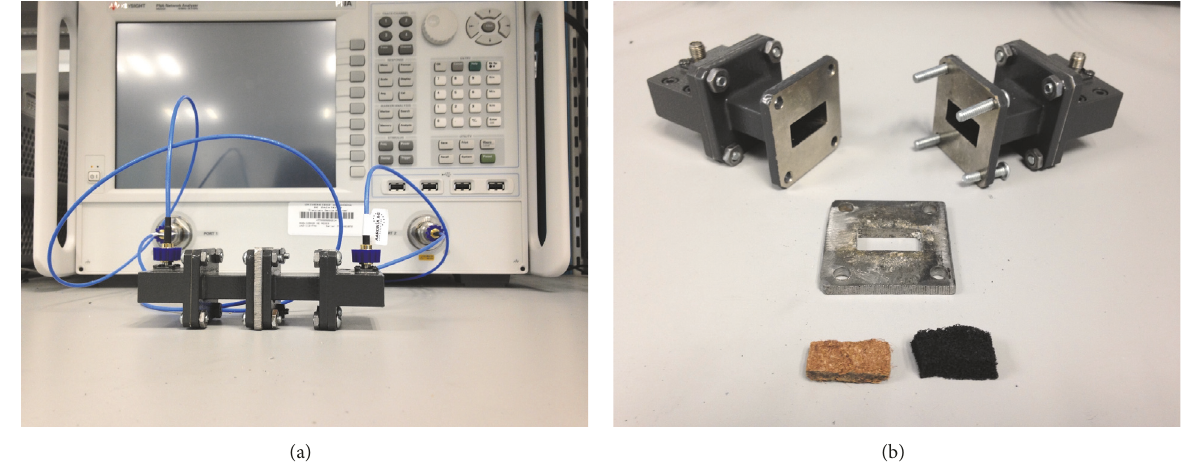
Figure 1: (a) The assembled experimental setup and (b) its components.